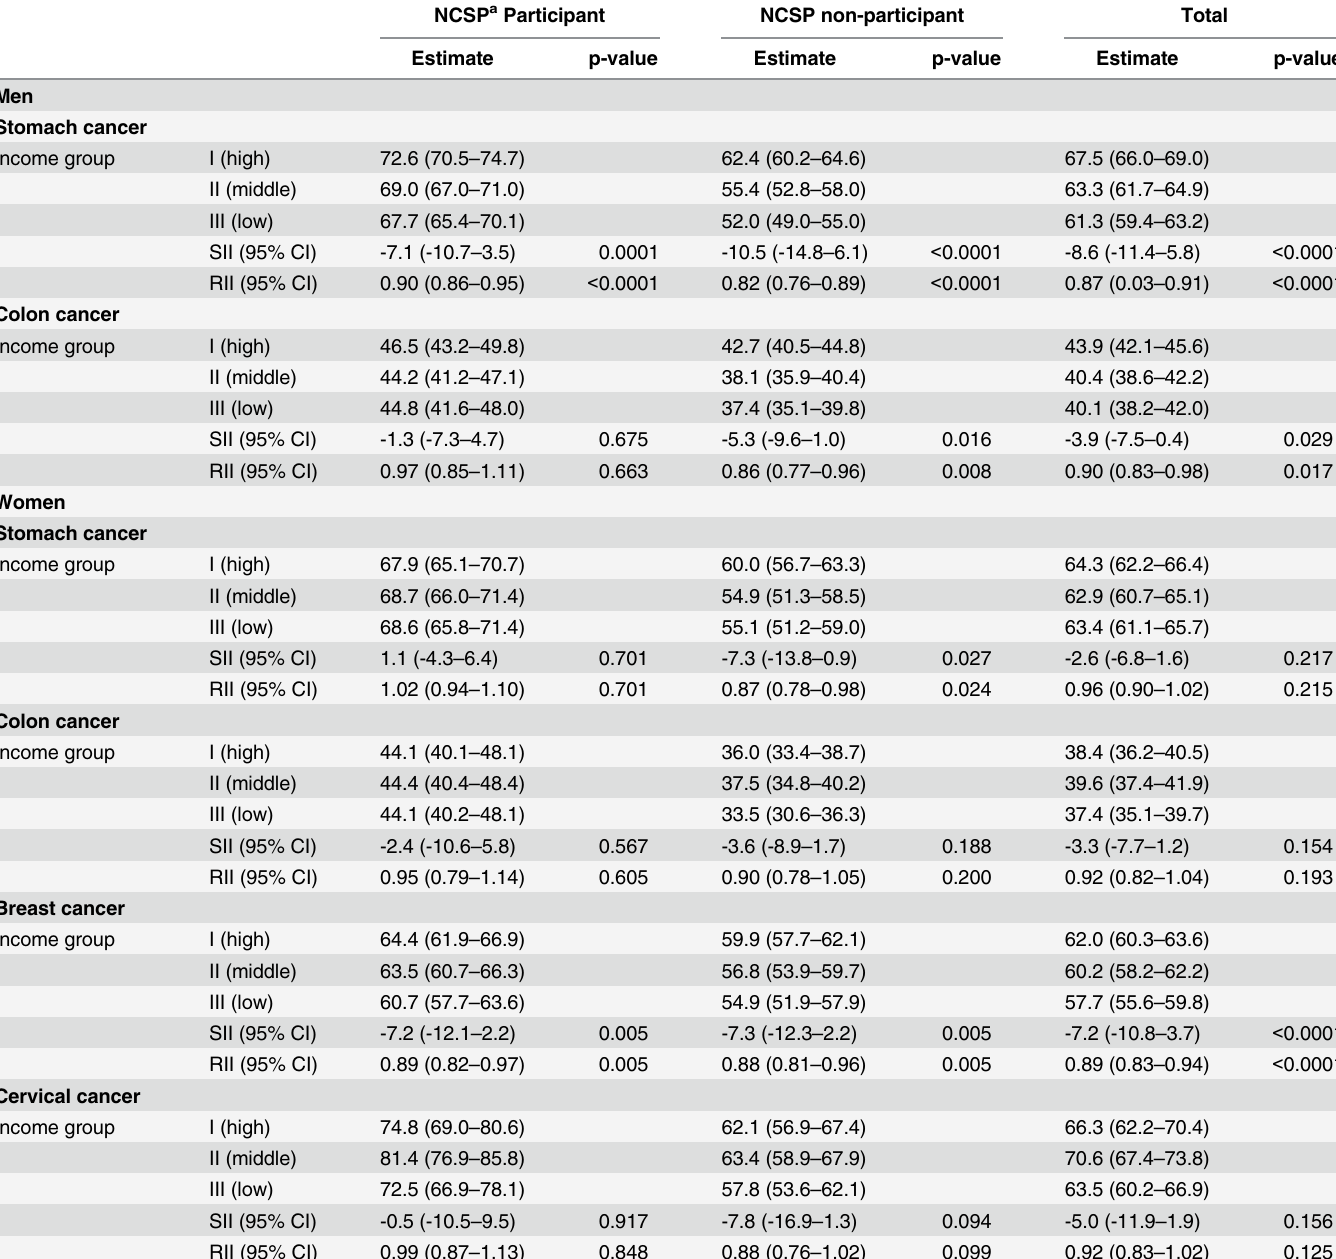
Table 3. Age-standardized prevalence rates (95% CI), prevalence difference (PD) and relative index of inequality (RII) of early-stage by National Cancer Screening Program